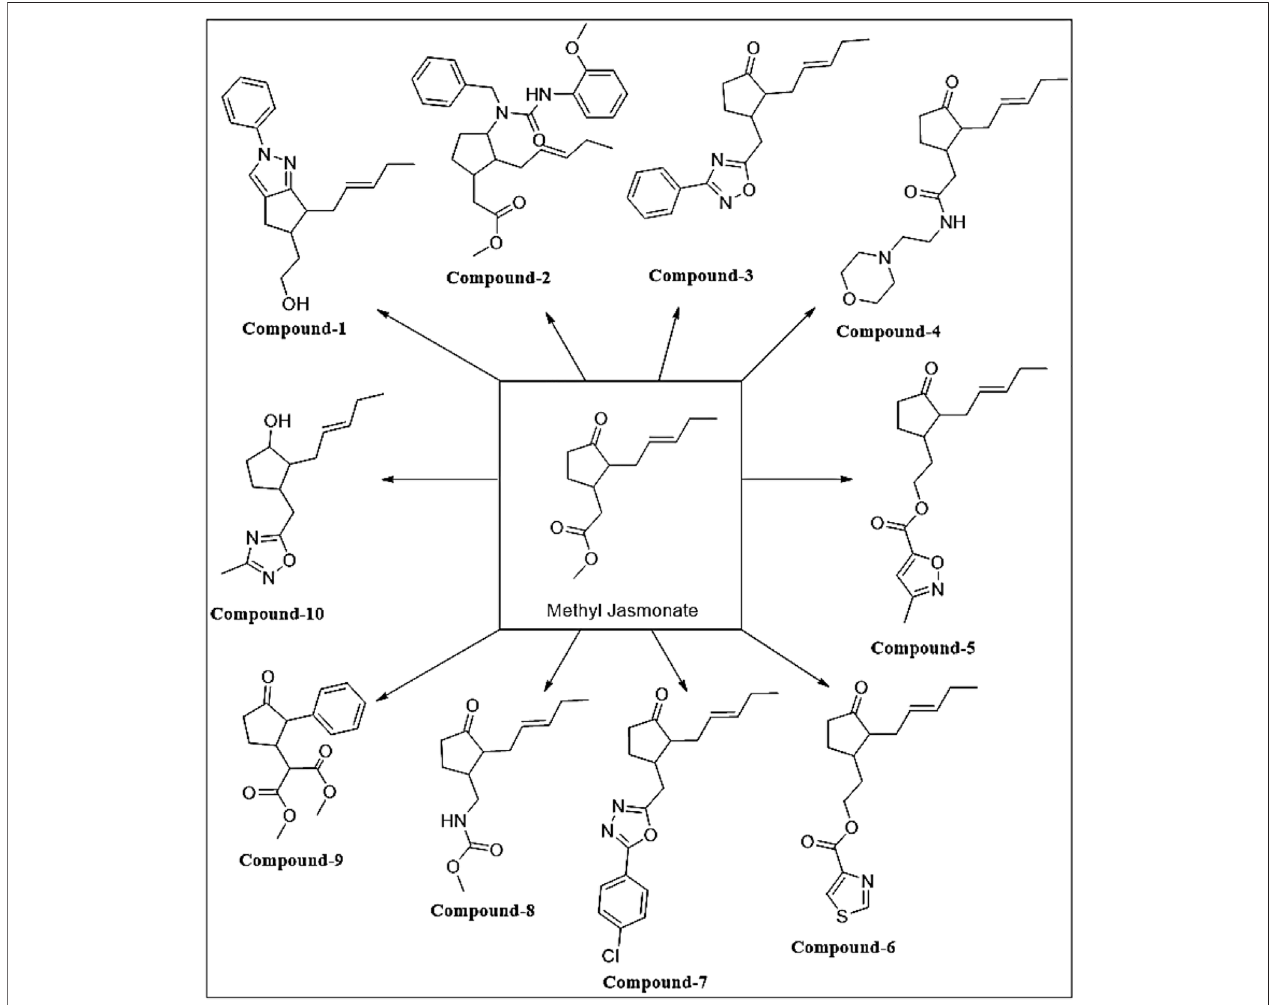
FIGURE 2 | Designed, synthesized and screened novel Methyl Jasmonate analogs as HK-2